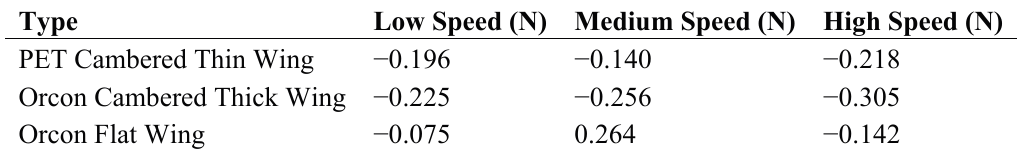
Table 3. Comparison of lift forces.